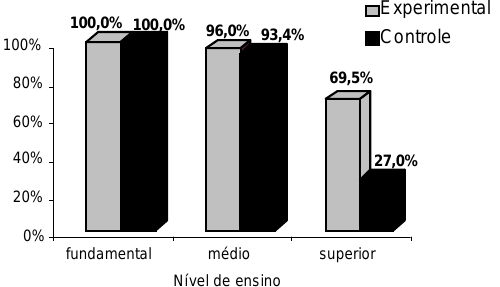
Figura 1. Distribui(cid:231)ªo dos grupos, por n(cid:237)veis de ensino, Figura 1. Distribuição dos Grupos, por Níveis de Ensino, com Relação aos Participantes que Nunca Interromperam seus Estudos com rela(cid:231)ªo aos participantes que nunca interromperam